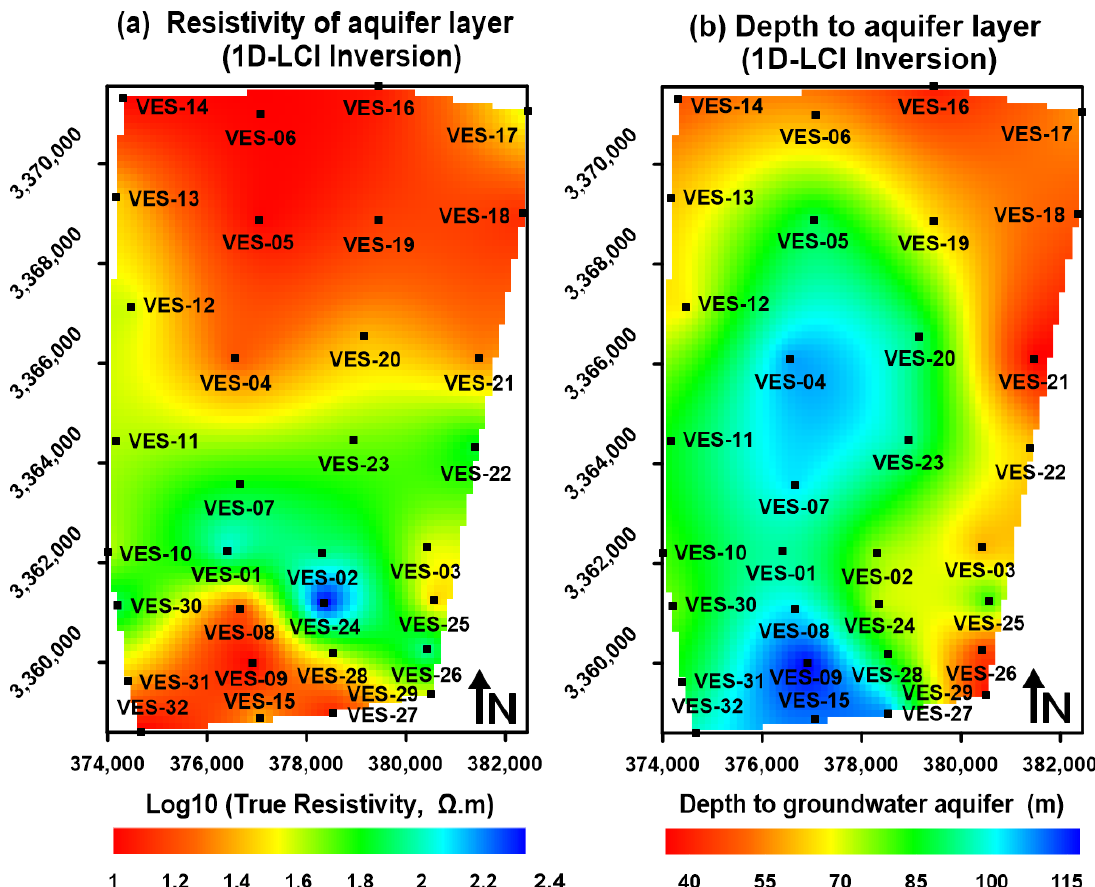
Figure 13. ( a ) Image map of true resistivity values from 1D-LCI inversion results in the study area and ( b ) image map of depth to top saturated zone of ground water aquifer from 1D-LCI inversion results in the study area.